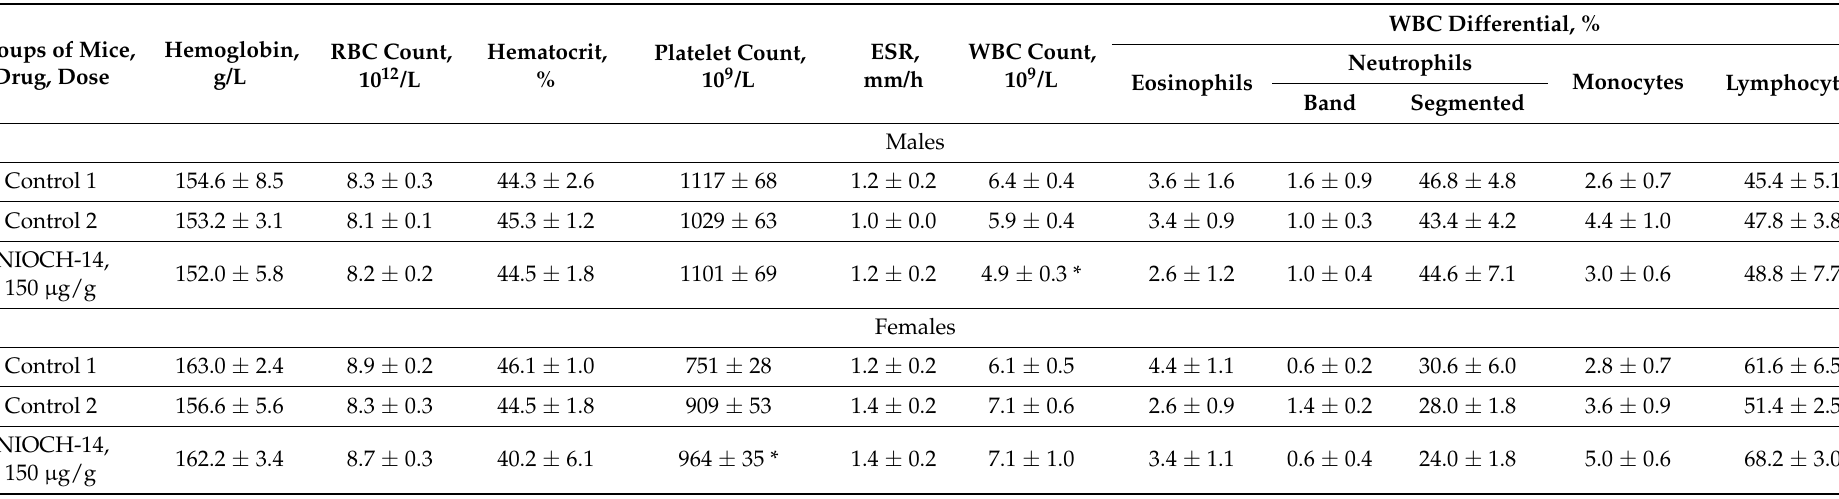
Table 1. Hematological parameters 14 days after single-dose intragastric administration of NIOCH-14 to outbred ICR mice (150 µ g/g body weight). Groups of